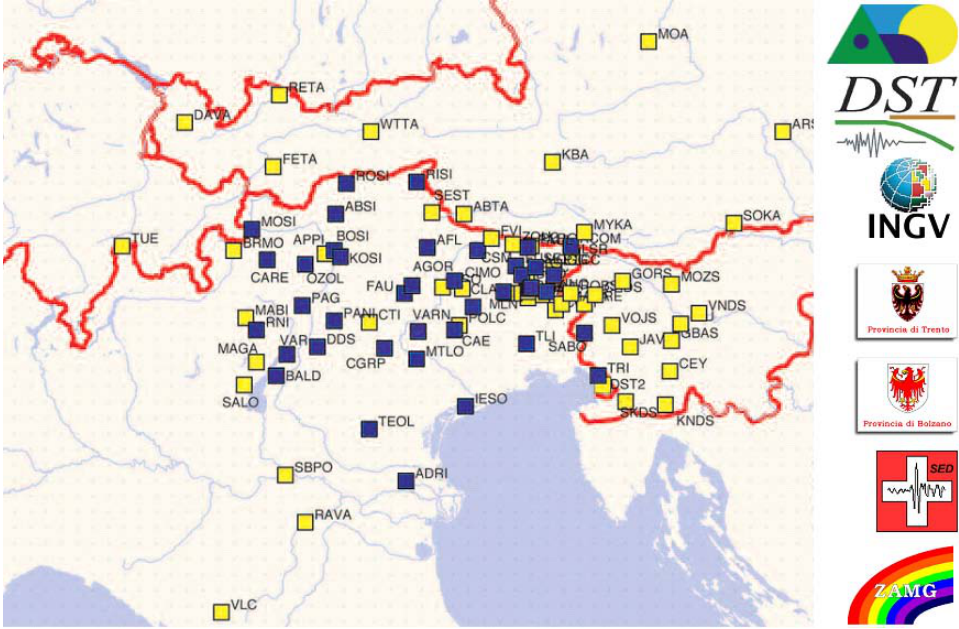
Fig. 1. The OGS Virtual Seismic Network: 33 OGS stations (blue squares) and 60 stations contributed by other institutions (yellow squares) in real time.